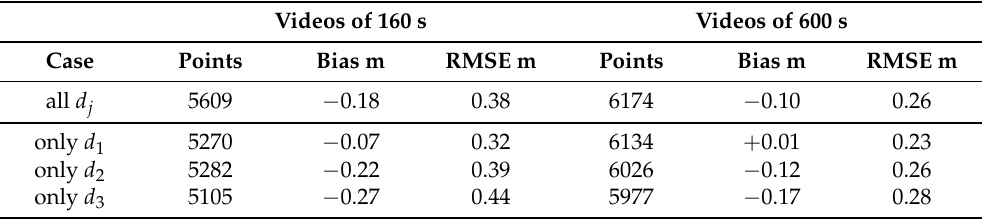
Table 2. Summary results for the bathymetry obtained for the cropped (160 s) and full (600 s) videos using all d j at once (as in UBathy) and using one each time. The reference case is “all d j ” with “videos of 160